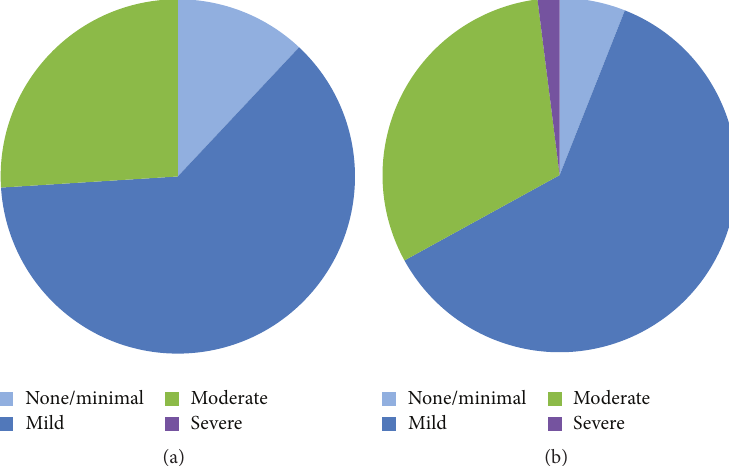
Figure 2: Postprocedural paravalvular aortic regurgitation in patients with low-flow low-gradient severe aortic stenosis (LFLGAS) and those with non-LFLGAS. (a) LFLGAS patients. (b) Non-LFLGAS patients.